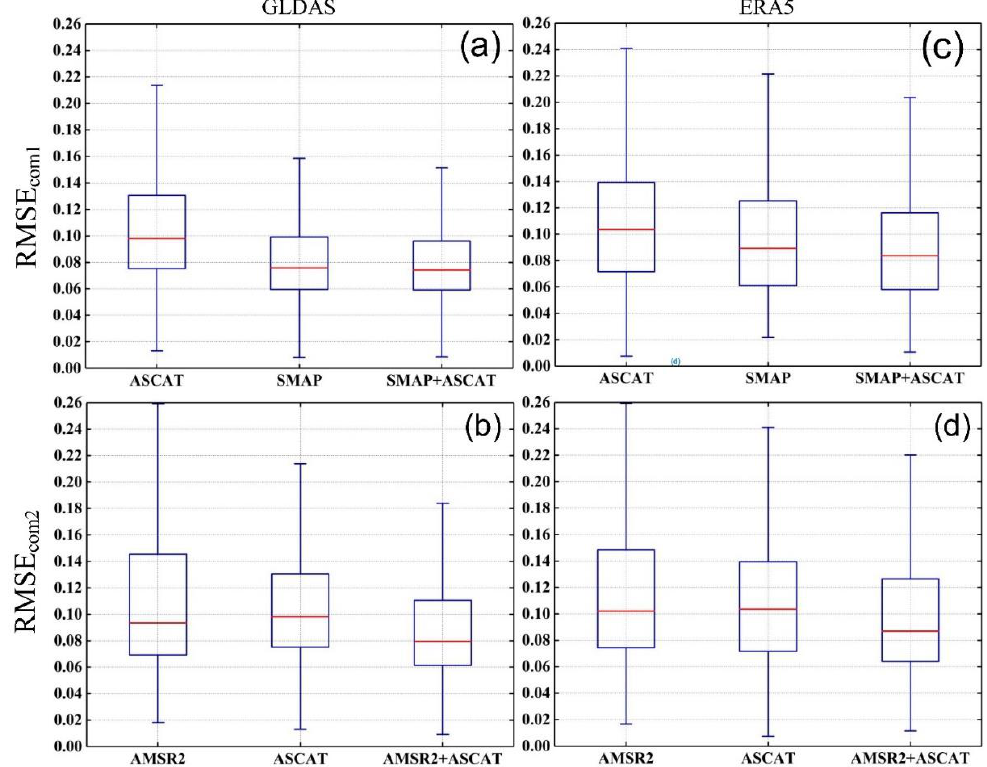
Figure 14. Box plots of RMSE of merged (SMAP+ASCAT and AMSR2+ASCAT) and parents (SMAP, AMSR2, and ASCAT) SM datasets against the modeling SM products (GLDAS and ERA5), where (SMAP+ASCAT) (first row), and (AMSR2+ASCAT) (second row): ( a , b ) for GLDAS, and ( c , d ) for ERA5. Note that, com1 and com2 refer to SMAP+ASCAT and AMSR2+ASCAT, respectively. The overall averages RMSE values with GLDAS SM dataset were (0.081, 0.096, 0.083, 0.105, and 0.119) m 3 m −3 for SMAP+ASCAT, AMSR2+ASCAT, SMAP, ASCAT, and AMSR2, respectively. While the overall averages RMSE values with the ERA5 SM dataset are (0.093, 0.101, 0.101, 0.109, and 0.121) m 3 m −3 for SMAP+ASCAT, AMSR2+ASCAT, SMAP, ASCAT, and AMSR2, respectively. In